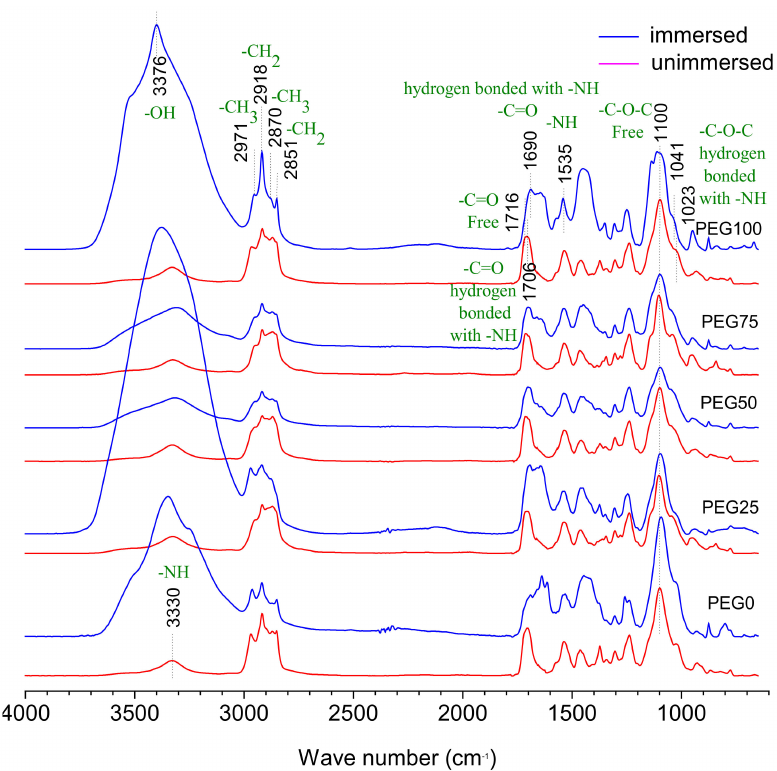
Figure 8. Attenuated total internal reflectance Fourier transform infrared (ATR-FTIR) spectra of the PEG-PU coatings.